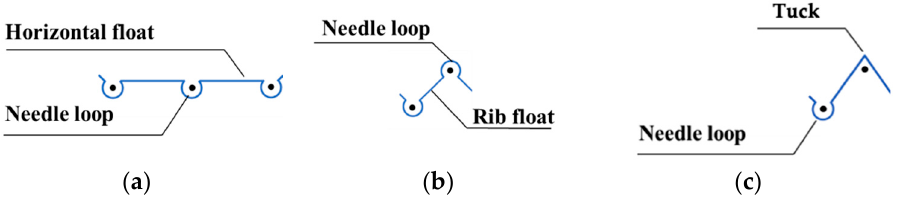
Figure 1. Graphic notation of the needle loop and horizontal float ( a ), rib float ( b ), and tuck ( c